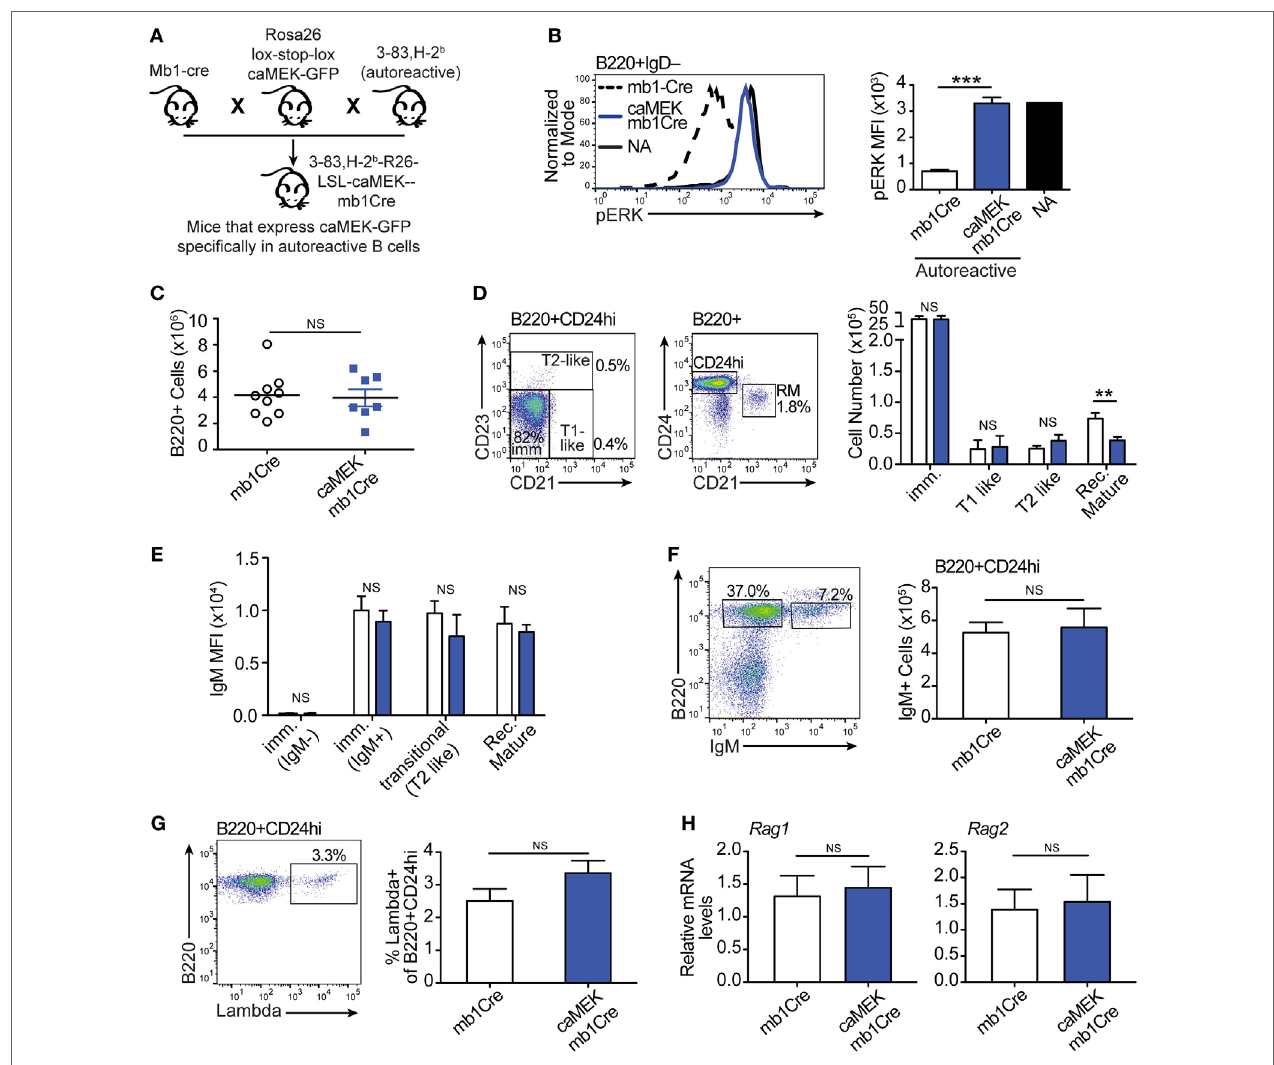
FigUre 4 | Constitutive extracellular signal-regulated kinase (ERK) activation does not rescue the in vivo development of autoreactive bone marrow B cells. (a) Schematic of the in vivo model for caMEK expression in autoreactive B cells. (B) Representative histograms and bar graph quantification of pERK levels in ex vivo immature B cells (B220 + IgD – ) from the bone marrow of NA (3-83Igi,H-2 d ) mice and autoreactive (3-83Igi,H-2 b ) mb1Cre or R26-LSL-caMEK-GFP-mb1Cre (caMEK-mb1Cre) mice. Cells were treated with pervanadate before pERK staining. (c) Absolute numbers of B220 + cells in the bone marrow of 3-83Igi,H-2 b mb1Cre and R26-LSL-caMEK-GFP-mb1Cre mice. (D) Gating strategy and bar graph quantification of cell numbers in bone marrow B cell populations from 3-83Igi,H-2 b mb1Cre and R26-LSL-caMEK-GFP-mb1Cre mice. B cell subsets were discriminated as: immature B cells (B220 + CD24 hi CD21 – CD23 – ), T1-like B cells (B220 + CD24 hi CD21 + CD23 – ), T2-like B cells (B220 + CD24 hi CD21 ± CD23 + ), and recirculating mature B cells (B220 + CD24 lo CD21 hi ). (e) Mean fluorescence intensity of IgM surface expression on B cells belonging to the B cell subsets gated as in (D) . (F) Gating strategy and quantification of the number of IgM + (edited) and IgM – (editing) cells within the bone marrow immature (B220 + CD24 hi ) B cell population from 3-83Igi,H-2 b mb1Cre and R26-LSL-caMEK-GFP-mb1Cre mice. (g) Gating strategy and quantification of the percentage of λ+ cells within immature (B220 + CD24 hi ) bone marrow B cells from 3-83Igi,H-2 b mb1Cre and R26-LSL-caMEK-GFP- mb1Cre mice. For panels (a–F) , N = 9 total 3-83Igi,H-2 b -mb1Cre mice and N = 7 total 3-83Igi,H-2 b -R26-LSL-caMEK-GFP-mb1Cre mice, analyzed in four independent experiments. (h) Relative Rag1 and Rag2 mRNA levels in B220 + or B220 + GFP + cells sorted from the bone marrow of 3-83Igi,H-2 b -mb1Cre or 3-83Igi,H-2 b -R26-LSL-caMEK-GFP-mb1Cre mice, respectively. Data were normalized to 18 s mRNA levels and are expressed as fold change over the average mRNA levels in 3-83Igi,H-2 b -mb1Cre cells. N = 3 mice from one experiment. In all panels, B cells from 3-83Igi,H-2 b R26-LSL-caMEK-GFP-mb1Cre mice were additionally gated on GFP + to analyze only the cells expressing caMEK. ** P ≤ 0.01, *** P ≤ 0.001, NS, not